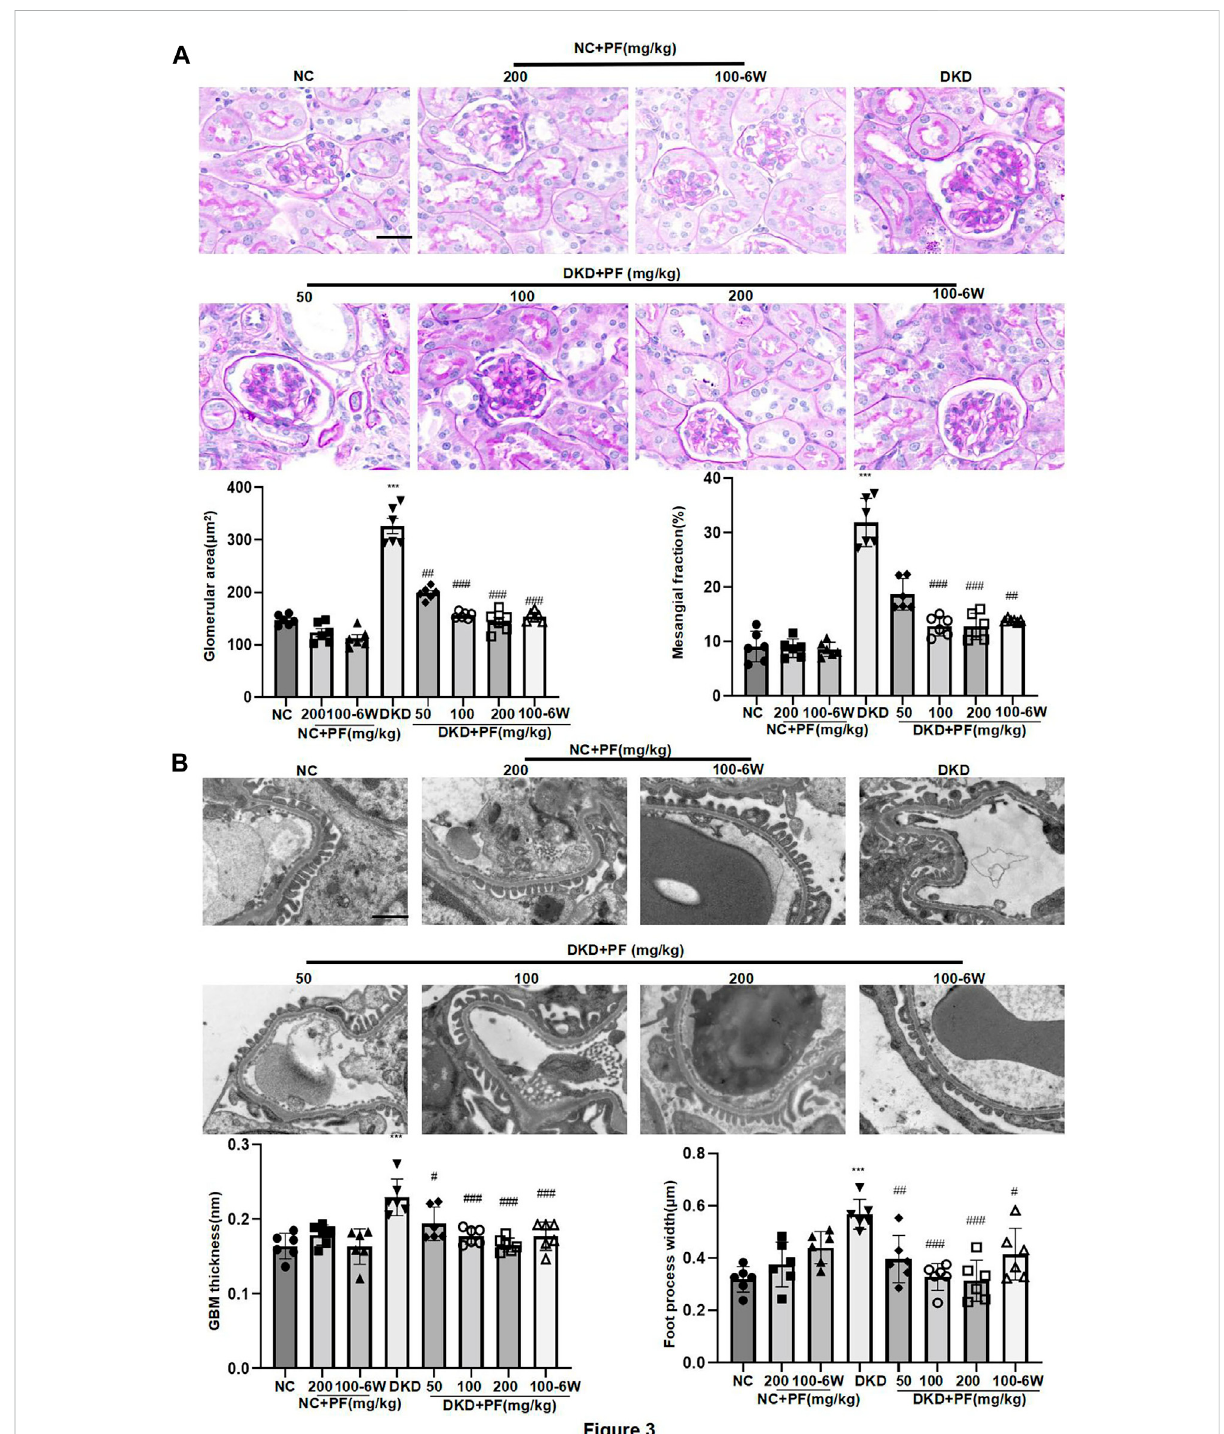
FIGURE 3 Morphological changes of STZ-induced diabetic mice. (A) Histopathological examinations of renal tissue sections stained with PAS from differentgroups,Scalebar=50 μ m. (B) ImagesofpodocytefootprocessesandglomerularbasementmembraneobservedbyTEM,Scalebar=1 μ m. Results represent the mean ± SD for 6 mouse/group. * p < 0.05, *** p < 0.001 vs. NC; ## p < 0.01, ### p < 0.001 vs. DKD. NC, normal control; PF, paeoni fl orin; STZ, streptozotocin; PAS, periodic acid – Schiff; TEM, transmission electron